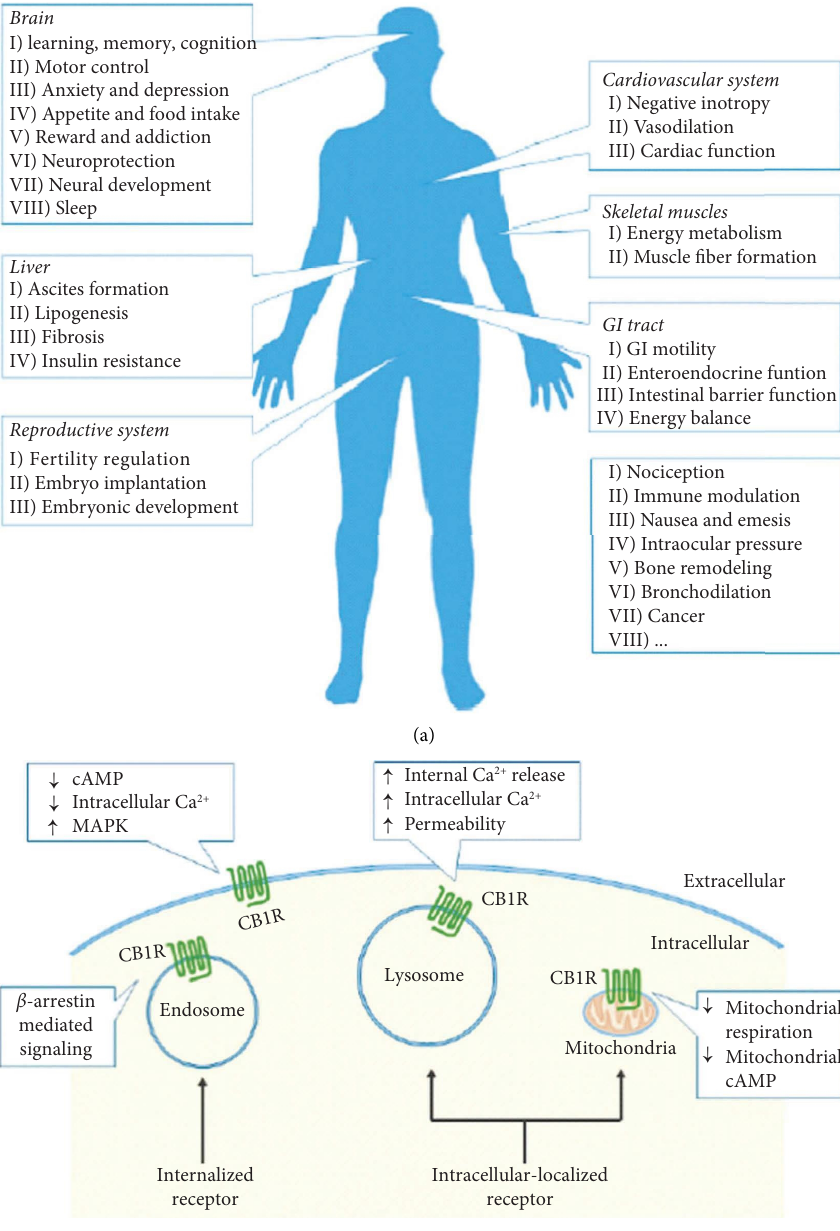
Figure 1: (a) Major localized sites and associated functions of the cannabinoid receptor type-1 in humans; (b) subcellular cannabinoid receptor type 1 localization (adapted from [91]). Cannabinoid receptor type-1 is widely spread in the brain and modulates the release of presynaptic neurotransmitter and many brain